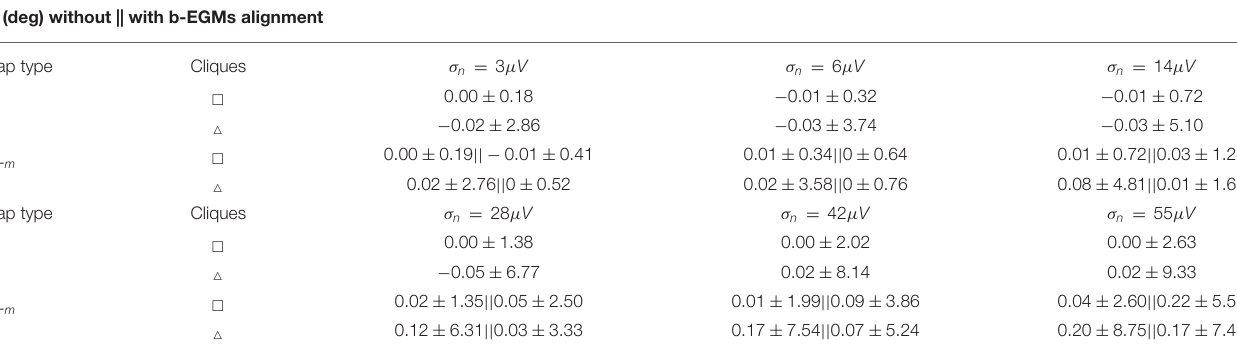
SD) estimated globally for all propagation direction maps performed with noisy b-EGMs with respect to clean map. ±